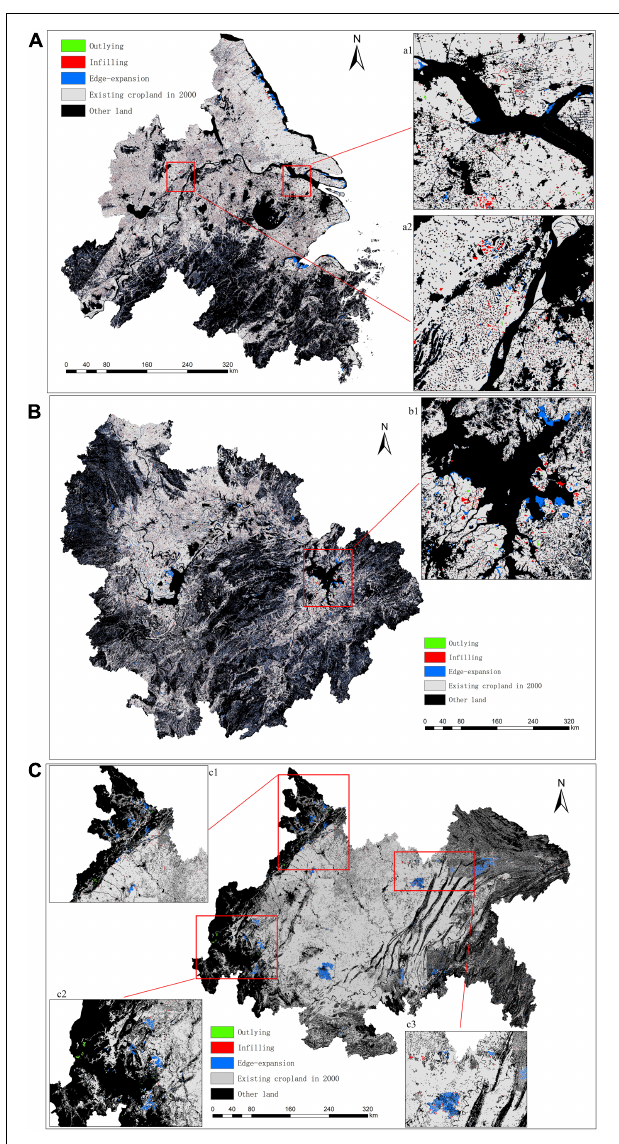
FIGURE 3 | Spatial distributions of different types of cropland expansion trajectories from 2000 to 2015 in (A) YRDUA, (B) MRYRUA, and (C) C&YUA.